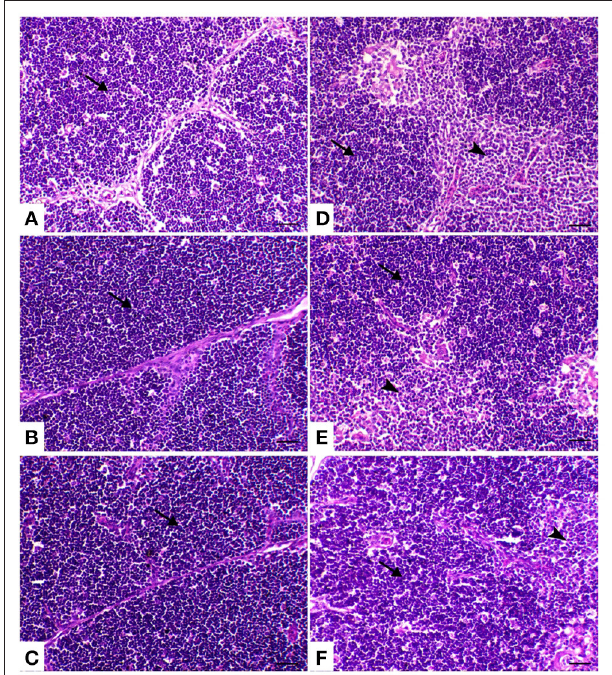
FIGURE 5 | Thymus sections of the different treated groups. (A) Thymus of the control group showing normal thymic compartments (the arrow indicates normal thymocytes). Sham groups (B) R and (C) E revealing normal thymic compartments. (D) Spleen of the heat stress (HS) group showing marked thymic depletion (arrow). (E) Spleen of HS + R showing medullary lymphoid depletion (arrowhead). (F) Spleen of HS + E showing a marked restoration of lymphoid content within the follicle. H&E, × 200, bar = 50 µ